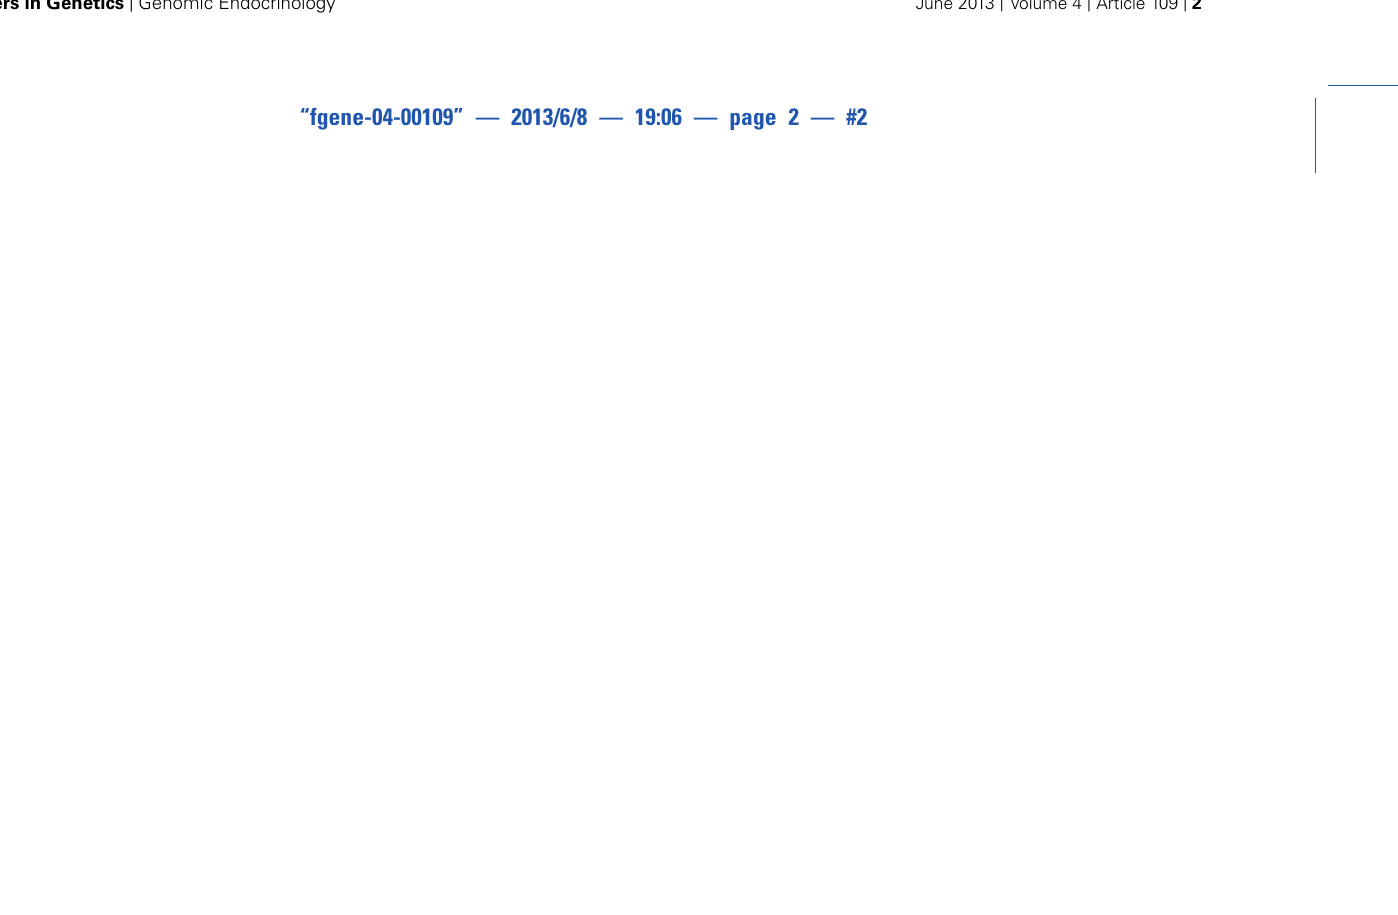
chaperones to assist with the protein production involved in secreting antibody. (C) Myeloma cells further activate the ER stress programs, involving PERK activation. All three arms are used by myeloma cells, although the CHOP response is limited. (D) Myeloma cells can be induced to further increase their ER stress response, tipping the system towards cell death. When ATF4 and ATF6 coordinate to induce transcription of CHOP, a pro-apoptosis transcription factor, the ER stress response moves from adaptive to destructive.This is the therapeutic goal of some drug regimens, such as